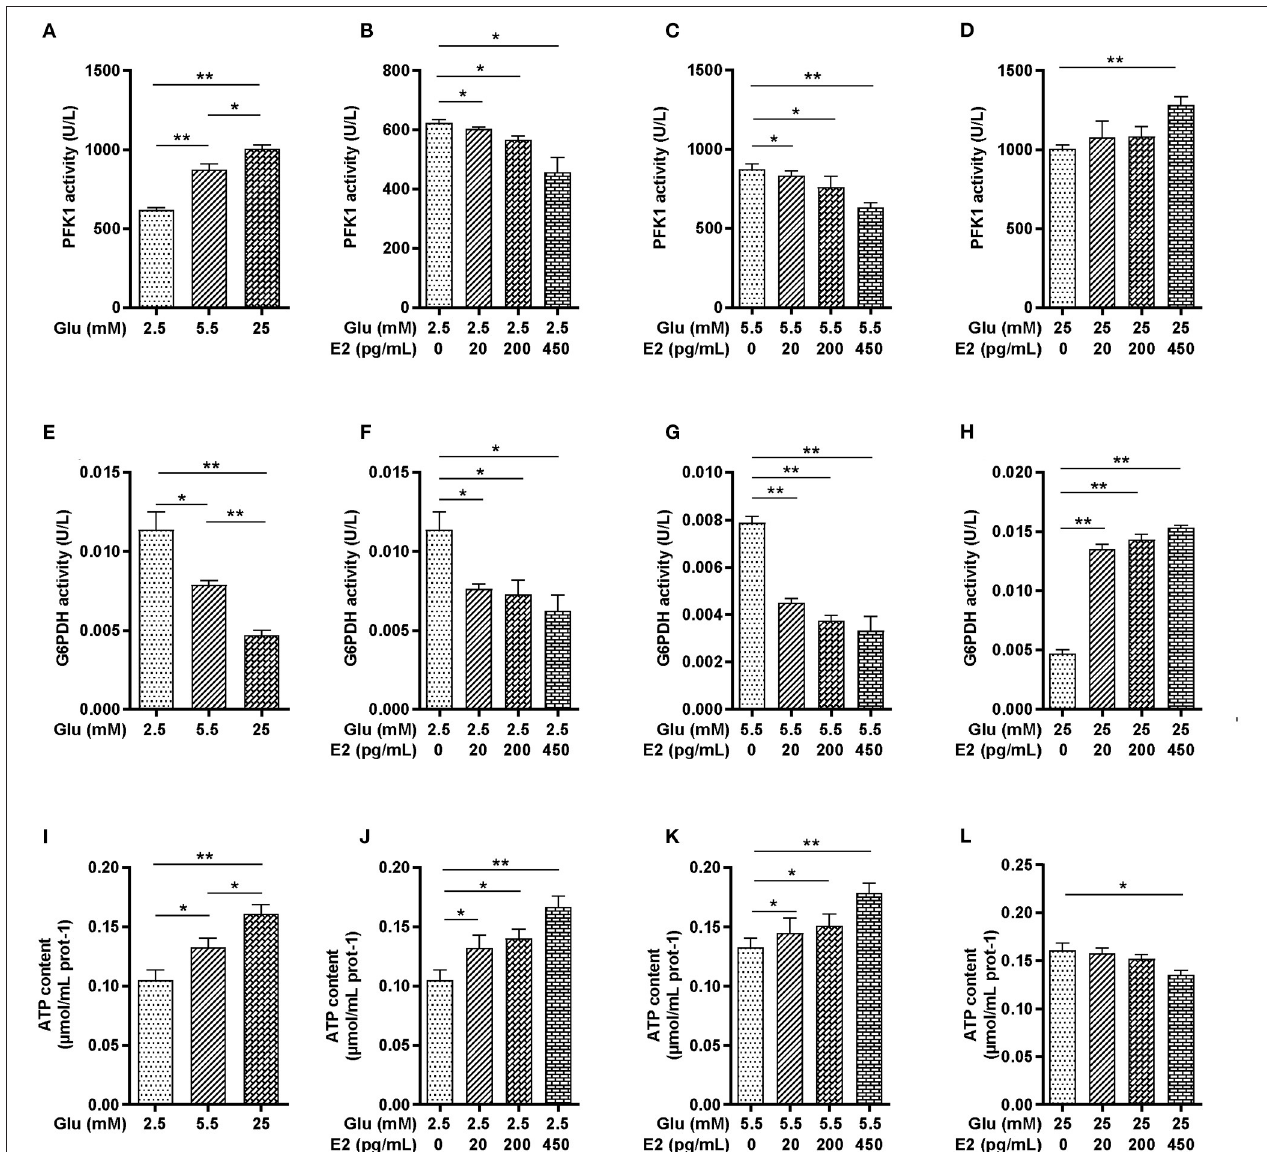
FIGURE 3 | E2 regulates the activity of PFK1 and G6PDH and maintains ATP homeostasis in PMNs. PMNs were treated with LG, NG, HG, LG + EL, LG + EM, LG + EH, NG + EL, NG + EM, NG + EH, HG + EL, HG + EM and HG + EH for 6h. (A–D) PFK1 activity was determined by ELISA. (E–H) G6PDH activity was determined by biochemical methods. (I–L) ATP contents were determined by biochemical methods. The results are shown as the mean ± SD ( n = 3). The significance of the difference was analyzed by the t- test. * P < 0.05, ** P <